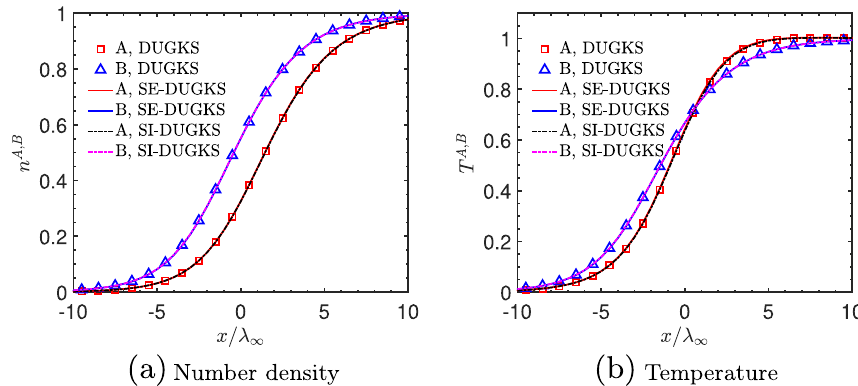
Fig. 4 Shock structure with Ma − = 1.5 , m B ∕ m A = 0.25 , and 𝜒 A = 0.1